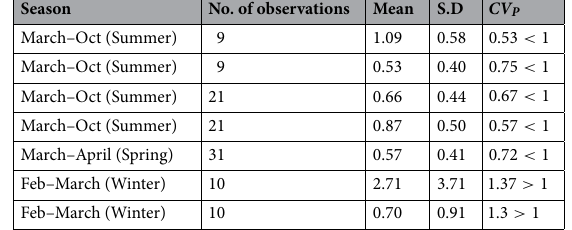
Table 6. Variation of CV P on surface waters of four different sampling stations of Funka Bay, Japan.